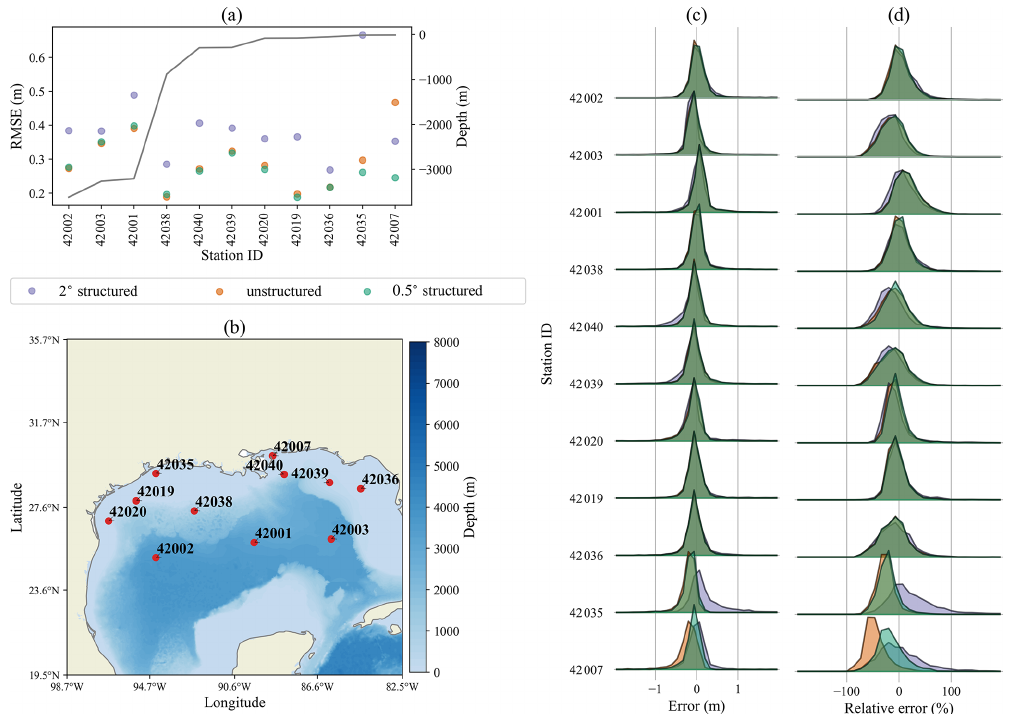
Figure 5. Same as Fig. 3 for stations in the Gulf of